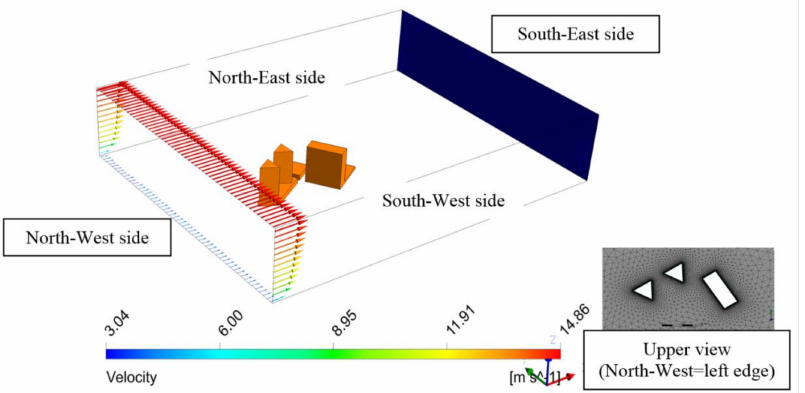
Figure 17. Layout of buildings in discrete environment and preview of wind speed profile.